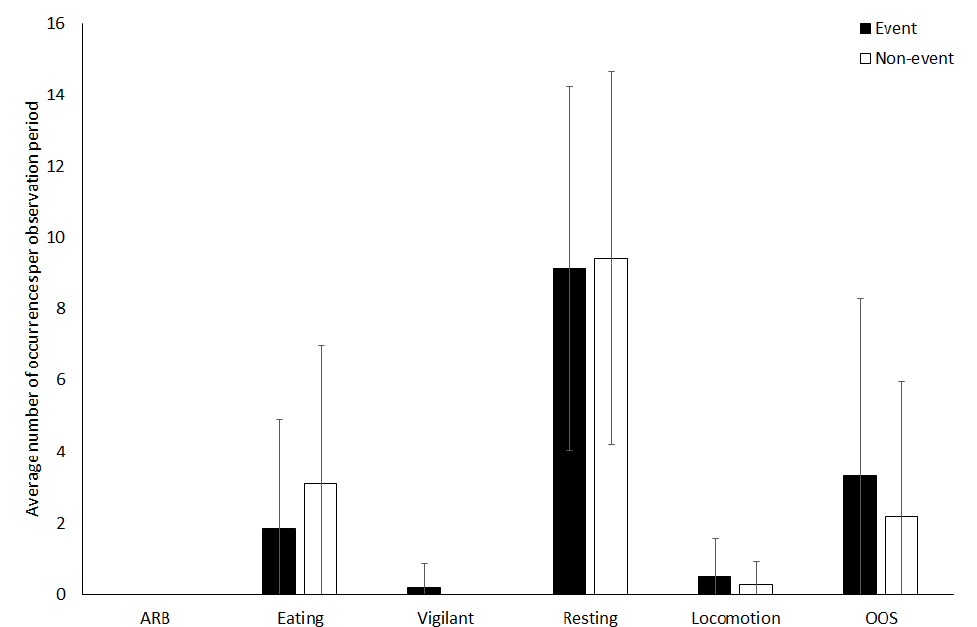
Figure 6. Activity budget data from 16:00 to 20:00 for three tapir (average number of occurrences of each behaviour within the group per observation period ± standard deviation) on event nights and non-event nights at Knowsley Safari. ARB: abnormal repetitive behaviour, OOS: out of sight of the observer.